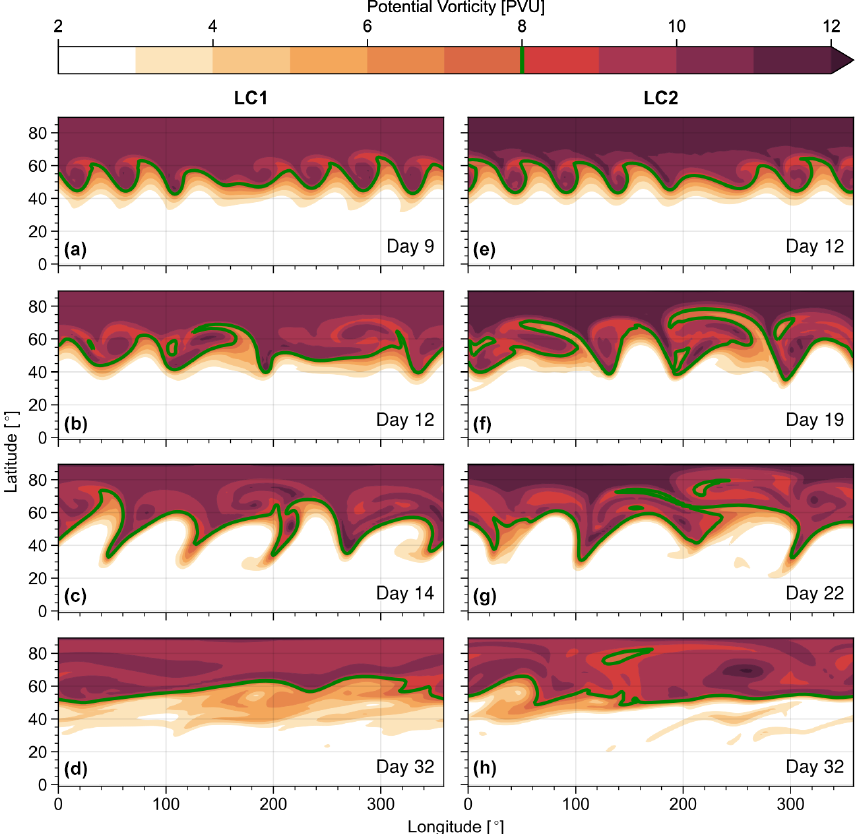
Figure 8. Potential vorticity on the 350K isentrope at different days for LC1 (a–d) and LC2 (e–h) initial conditions and strong initial noise perturbations ( η = 10 3 ). The 8PVU contour is highlighted as visual